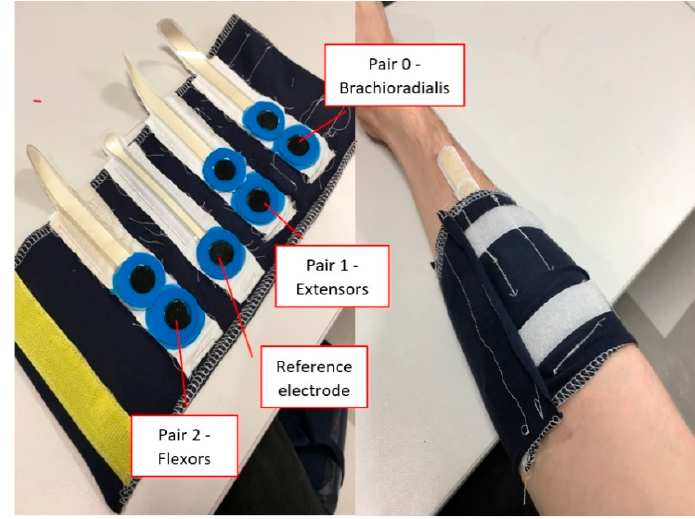
Figure 5. Final measurement